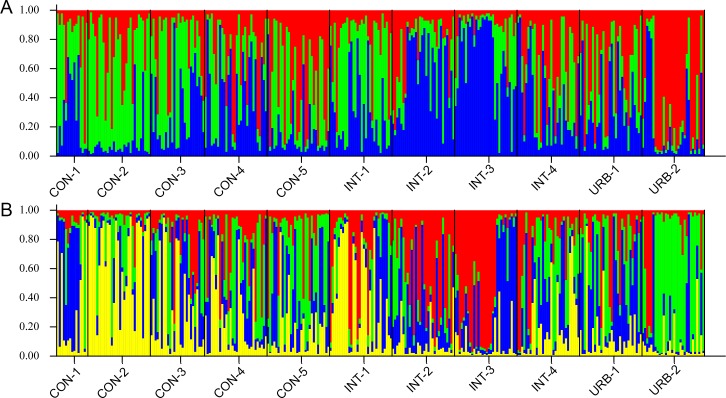
Bayesian analysis of population structure for all Aedes aegypti populations showing the subdivision of individuals for K = 3 (A) and K = 4 (B).Each of the 311 individuals from eleven populations is represented by a vertical line divided into different colored segments. The length of each segment represents the probability of the individual belonging to the genetic cluster represented by that color.